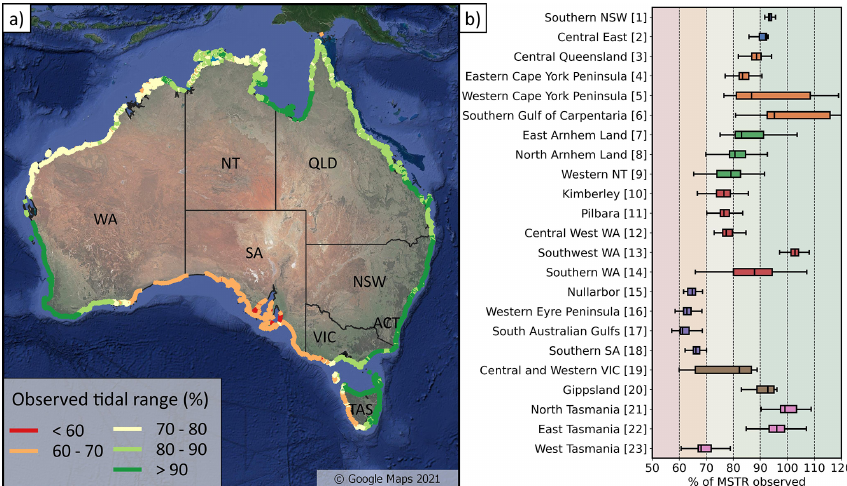
Figure 7. Observed tidal range by the satellite-derived shorelines. Panel (a) maps the % of the MSTR that is observed at each beach and (b) shows the distribution of that metric across the 23 coastal regions.